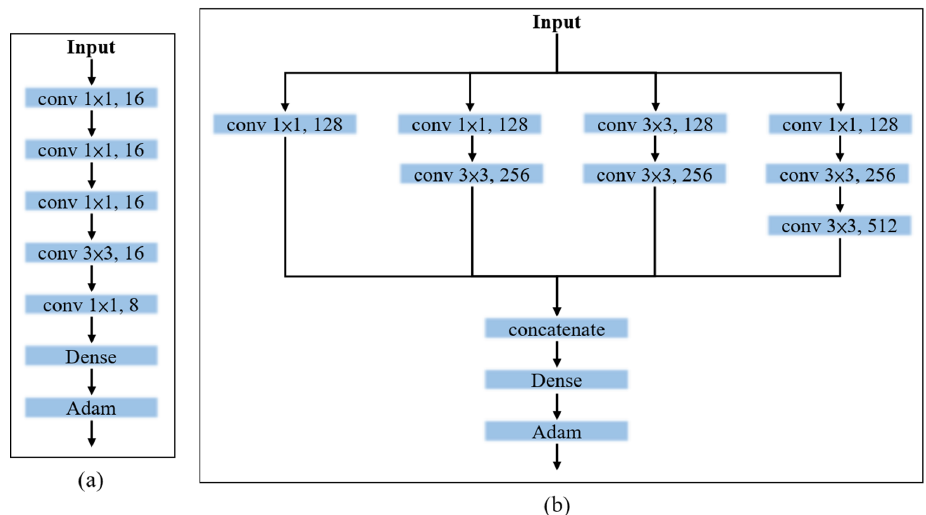
Figure 4. Two convolutional neural network (CNN) architectures: ( a ) Simple CNN; and ( b ) Incep- tion.